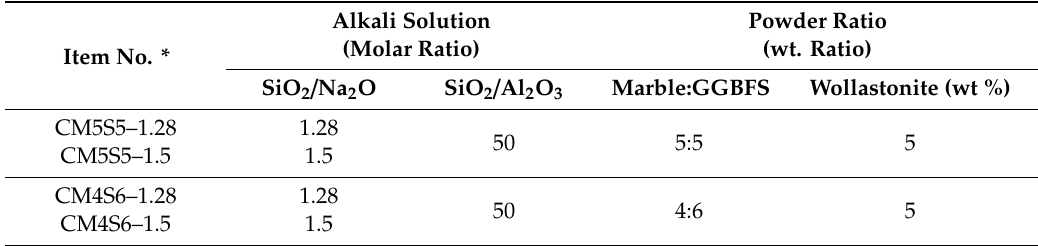
Table 2. Mix proportions of the marble-based geopolymer concrete.